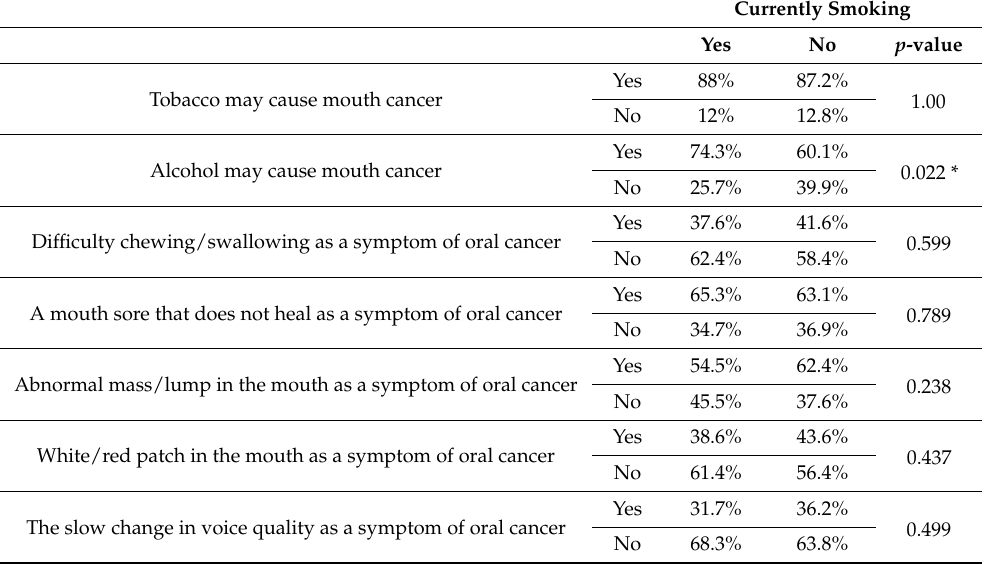
Table 2. Statistical analysis of survey questions according to the current use of cigarettes. * shows statistical significance ( p <